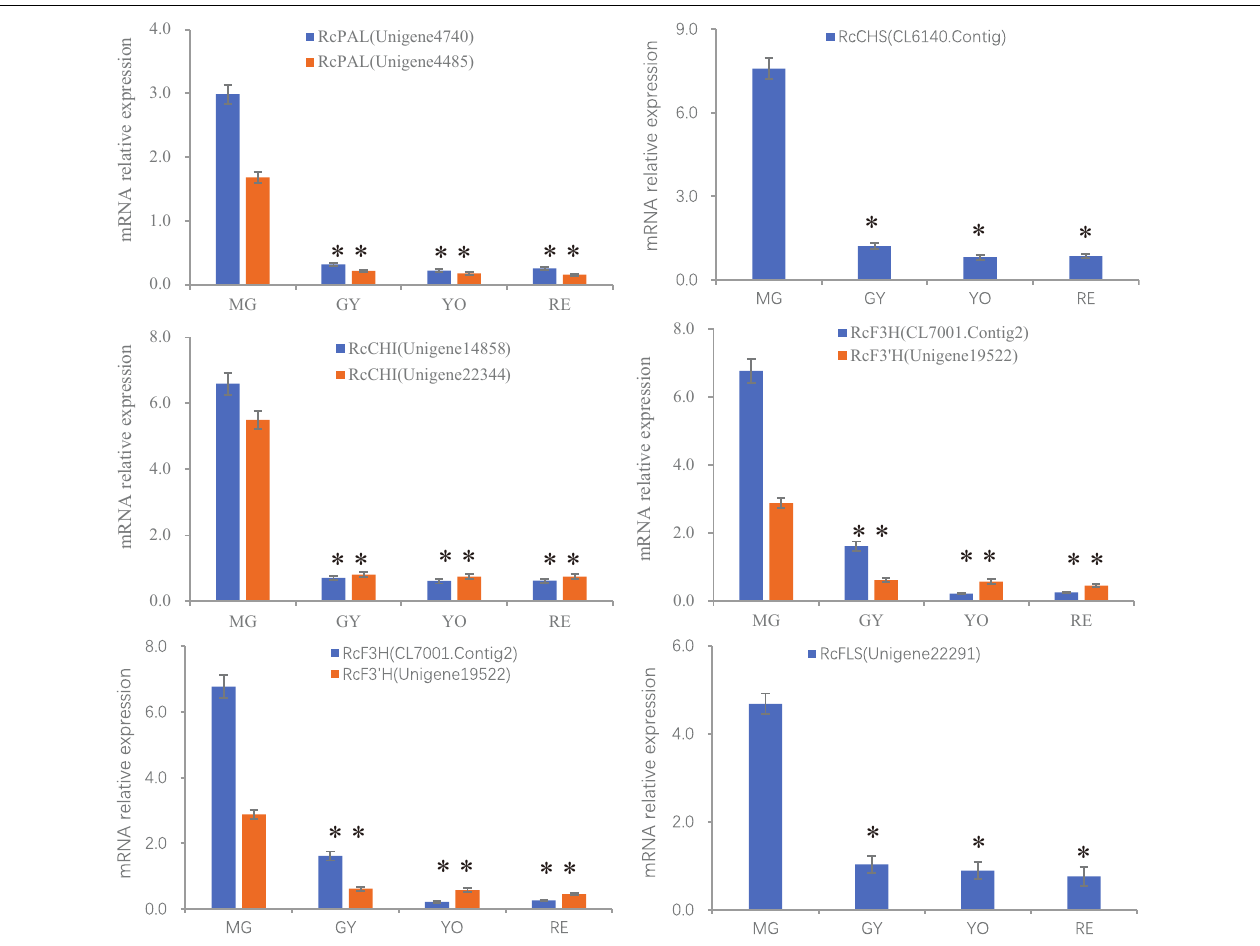
FIGURE 5 | The relative expression of genes (PAL, CHS, CHI, F3H, F3 (cid:48) H, and FLS) involved in flavonoid production during the process of fruit maturation in R. chingii. The expression was estimated by real-time PCR. Actin gene was inner control. ∗ indicates comparison between other phases and MG, T-Test, significant ( P < 0.05).